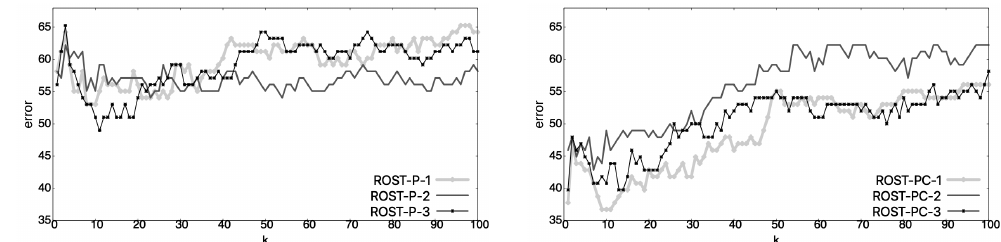
Figure A1. Evolution of error in k-NN for k values from 1 to